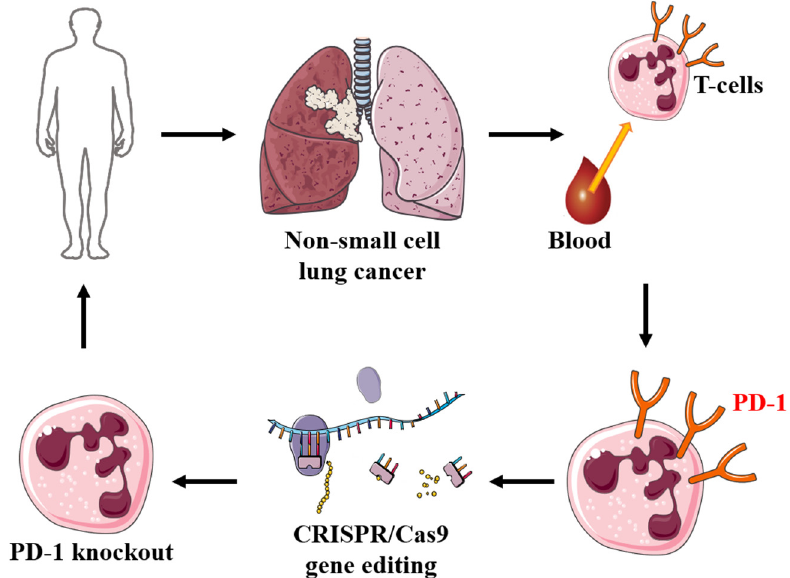
Figure 4. Targeted PD-1 gene modification in T cells in the first clinical trial of non-small cell lung cancer using CRISPR/Cas9 technology: peripheral blood lymphocytes were collected from the patient with the non-small cell lung cancer. The CRISPR/Cas9 mediated knockout of the immune checkpoint gene PD-1 was performed in human T-cells. The PD-1 knockout T-cells were expanded in vitro and then transfused back to the patient, thereby inducing an immunological response against tumor cells.